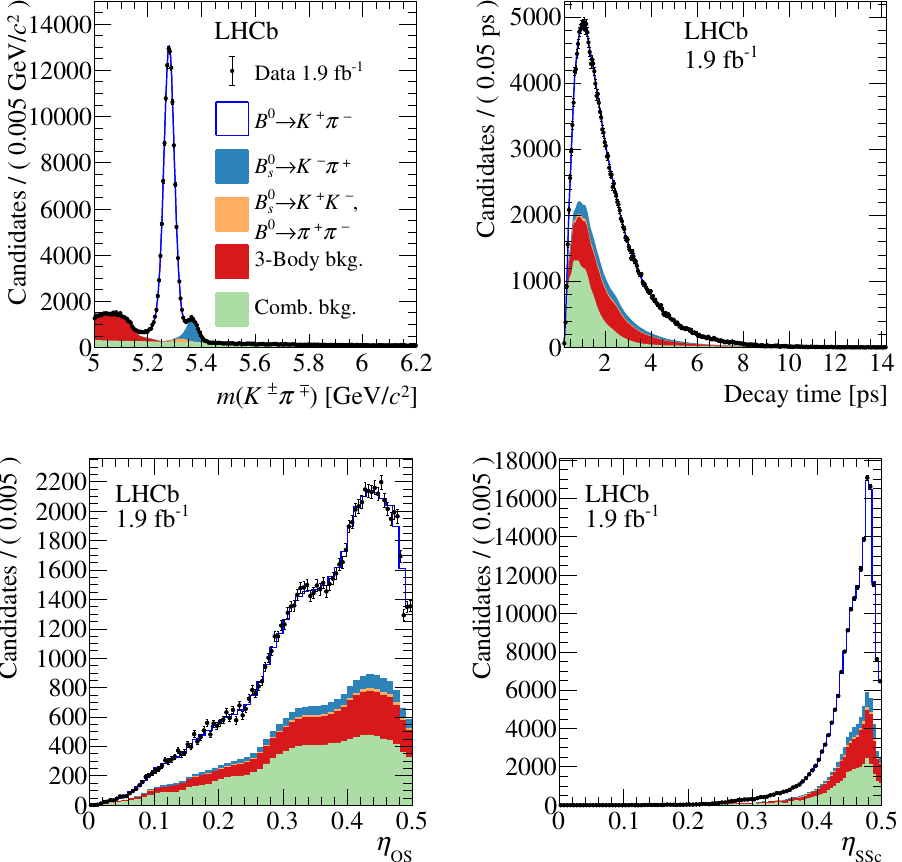
Figure 2 . Distributions of (top left) K (cid:6) (cid:25) (cid:7) invariant mass, (top right) B 0 fractions (bottom left) (cid:17) OS and (bottom right) (cid:17) SSc for K (cid:6) (cid:25) (cid:7) candidates. The result of the simul- taneous (cid:12)t is overlaid. The various components contributing to the (cid:12)t model are drawn as stacked